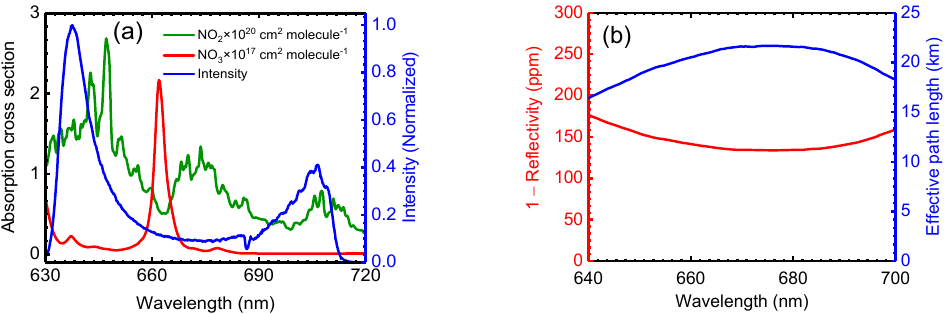
Figure 2. ( a ) The green and red spectrum are the absorption cross section of NO 2 and NO 3 convolved from Voigt et al. [47] and Yokelson et al. [6], respectively. The transmitted light intensity is shown as the blue line. ( b ) Mirror loss expressed as (1 − R ) and the corresponding effective path length.